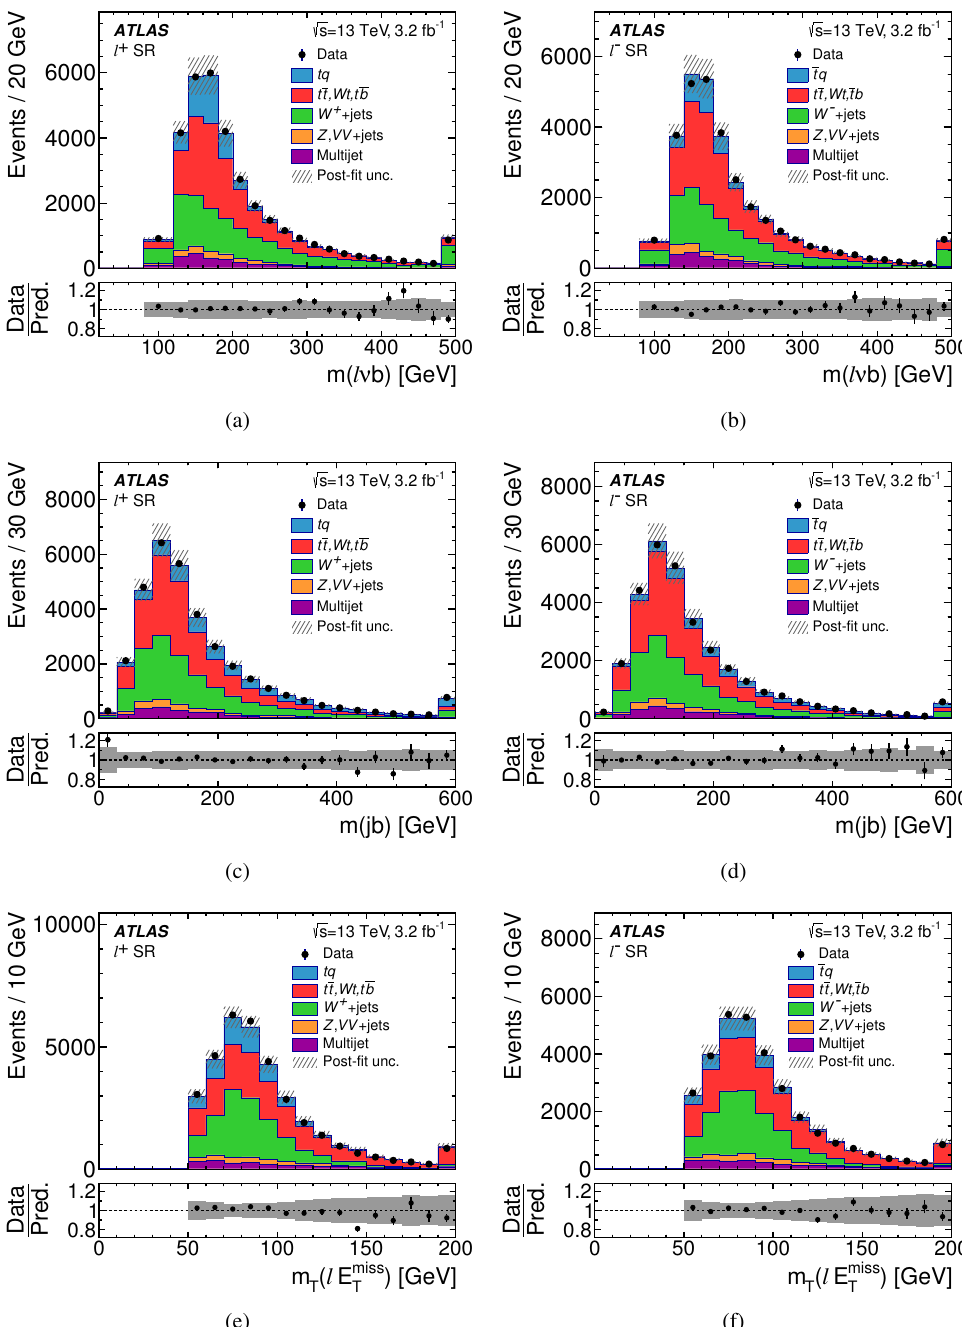
Figure 5 . Distributions of the three most important variables (left) for the ‘ + channel and (right) for the ‘ (cid:0) channel normalised to the fit result. (a)-(b): reconstructed top-quark mass m ( ‘(cid:23) b ), (c)-(d): invariant mass of the jet pair m ( jb ), (e)-(f): transverse mass of the W boson m T ( ‘ E miss ). The hatched and grey error bands T represents the post-fit uncertainty. The ratio of observed to predicted (Pred.) number of events in each bin is shown in the lower histogram. Events beyond the x -axis range are included in the last